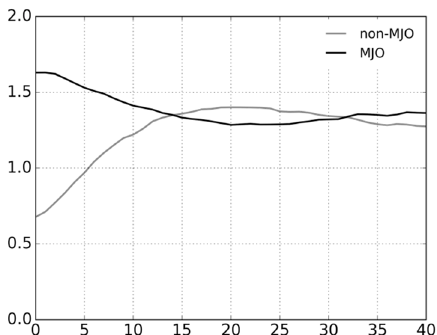
Figure 10. The standard deviation of analysis time segments as a function of lead time for forecasts initialized at the MJO state (black) and forecasts initialized at the non-MJO state (gray).